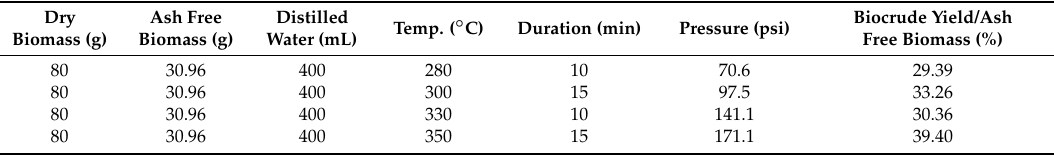
Table 2. Effect of different temperatures, time durations, and pressures on bio-crude yield of A. coffeaeformis RR03 biomass obtained from 10.0 m 2 open raceway pond without CO 2 supplementation. Dry Biomass